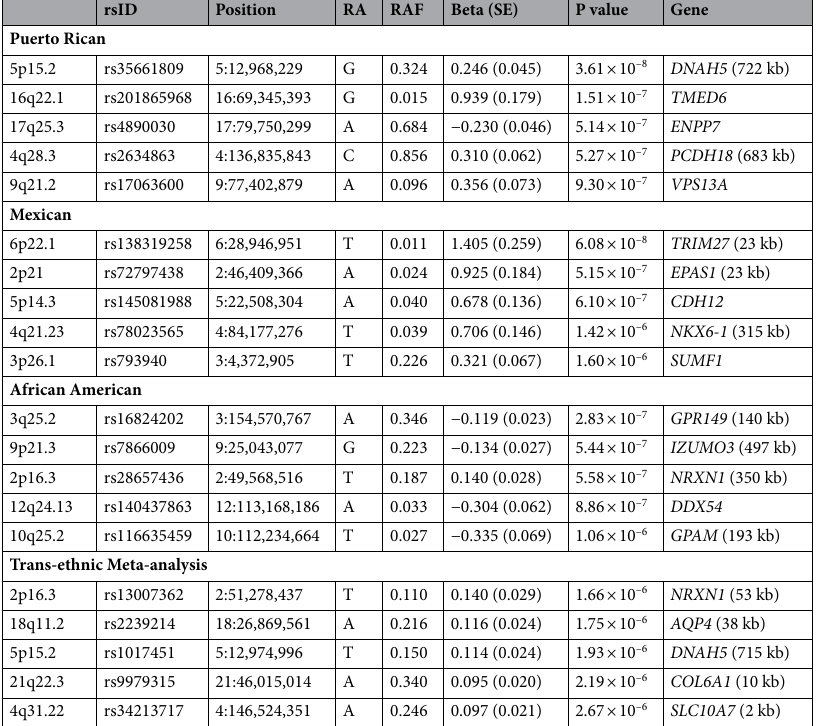
Table 2. Top 5 loci and their lead variants in BDR GWAS. Genomic position is based on GRCh38. The nearest protein-coding gene was defined by kb distance with respect to the lead variant when it is not located within the gene. RA: risk allele; RAF: risk allele frequency; SE: standard